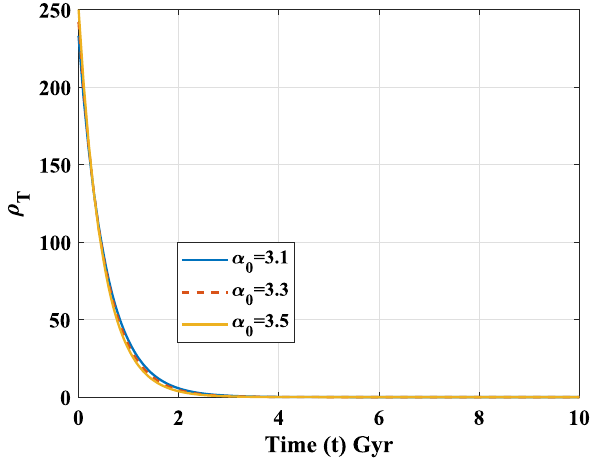
Fig. 2 Plotofenergydensity( ρ T )ofTHDEversustime( t )for k = 1 . 9, α = 1 . 2, α = 0 . 52, and γ = 101 Fig. 3 Plot of energy density ( ρ 1 2 1